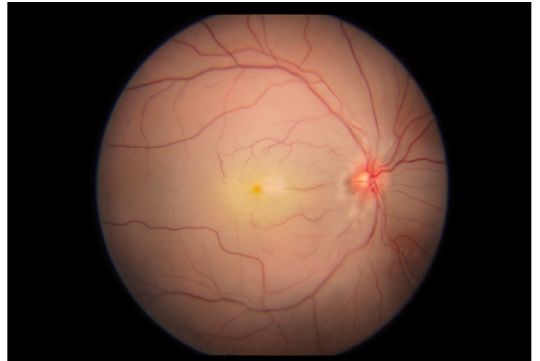
Fig. 1. Pale retina with cherry red spot on right fundus